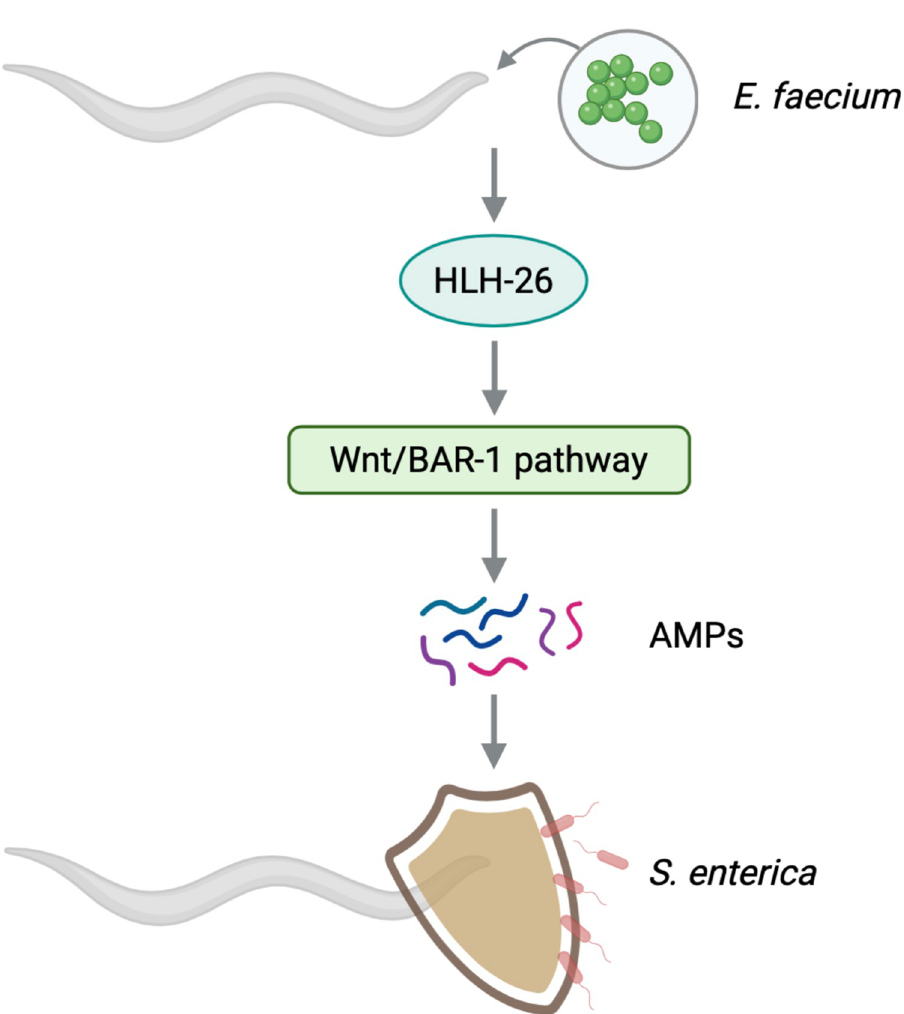
Fig 7. Transcription factor HLH-26 mediates probiotic protection via Wnt/BAR-1 Signaling. HLH-26 protection against S . enterica infection is partly due to activation of the canonical Wnt/BAR-1 pathway. The binding of Wnt to its receptors leads to β -catenin stabilization and translocation to the nucleus, coactivating target gene transcription. Expression of Wnt/BAR-1 target genes enhances antimicrobial peptide production, which inhibits pathogen infection. AMPs, antimicrobial